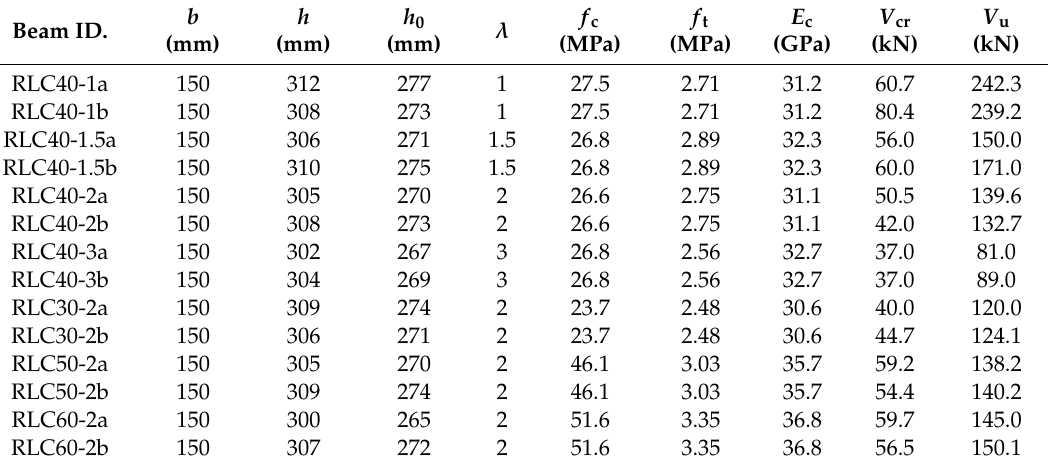
Table 4. Main test data of reinforced CRAC